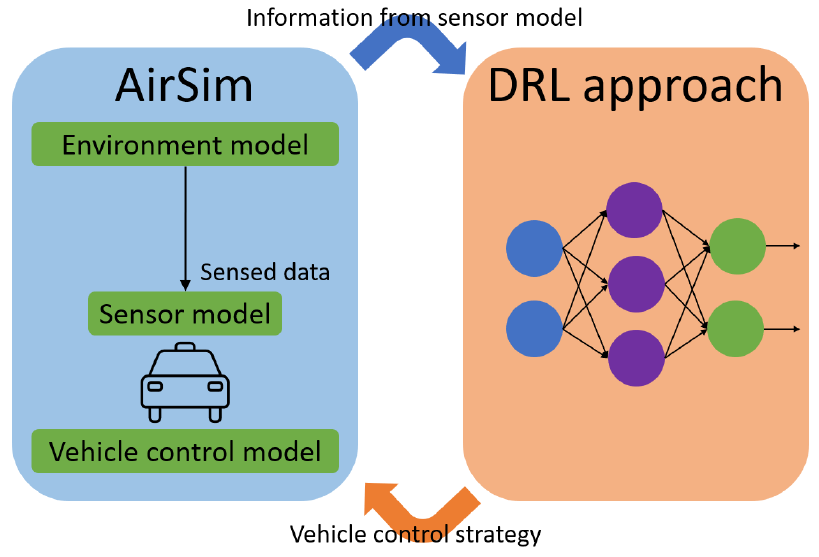
Figure 4. The architecture of our